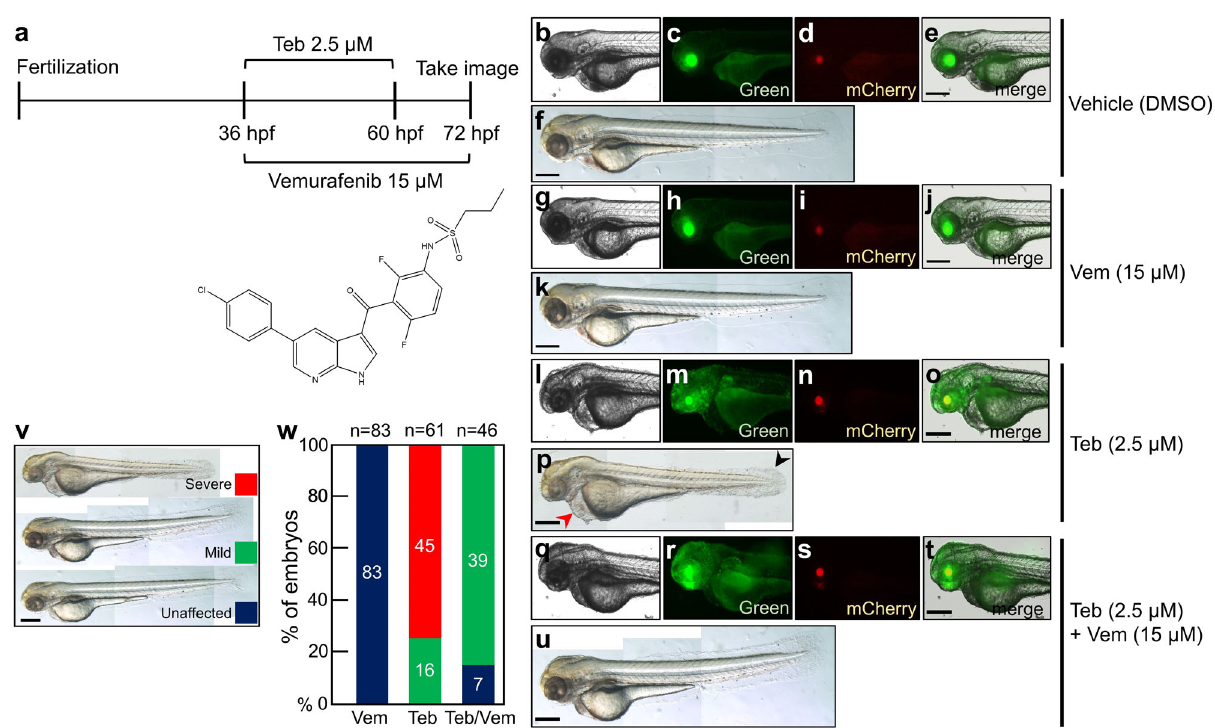
Fig. 3 Modeling RASopathy disease with BRAF (V600E) overexpression using IQ-Switch. a While a low dose of Teb (2.5 µ M) was used to treat the genetic cross of Tg ( ubb : QFDBD-2xAD*-VP16*-EcR, α -cry:EGFP ) and Tg ( 5xQUAS : ZsGreen-P2A-BRAF V600E , α -cry:mCherry ) from 36 hpf to 60 hpf, 15 µ M of vemurafenib was added to the transgenic embryos for an extended period from 36 hpf to 72 hpf. The live embryos were observed under an epi fl uorescence microscope at 72 hpf. The chemical structure of vemurafenib is shown below. b – u While green fl uorescence in the lens manifested the existence of a driver cassette, mCherry in the lens represented an effector 5xQUAS : ZsGreen-P2A-BRAF V600E transgene in the genome. b – f DMSO vehicle treatment. g – k Treatment with 15 µ M of vemurafenib alone. l – p Treatment with 2.5 µ M of Teb alone. The embryos showed ZsGreen reporter expression in whole tissues. q – u A representative image of embryos exposed simultaneously to both Teb (2.5 µ M) and vemurafenib (15 µ M). Similar to that of Teb alone, green fl uorescence was detected in all tissues. v Embryos were classi fi ed into three groups following embryonic malformation. w A graphical view of the embryonic defects as in ( v ). n represents the number of embryos analyzed. Abbreviations: Teb; tebufenozide, Vem; vemurafenib. Scale bar; 150 μ